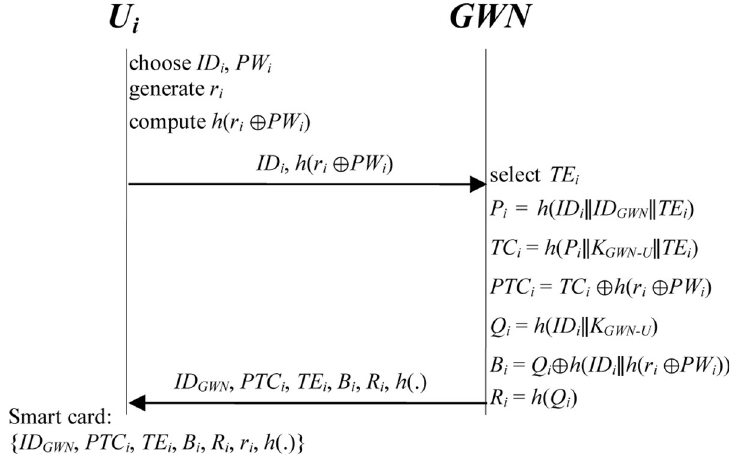
Fig 2. Registration phase for users in the proposed scheme.